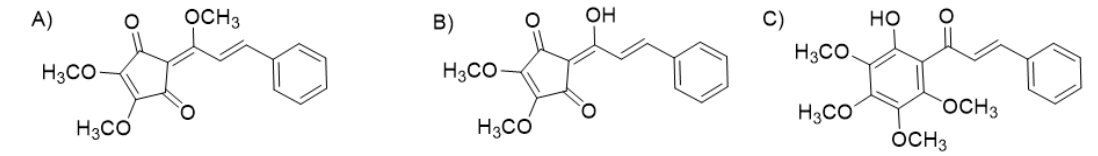
Figure 4. Structures of methyllinderone ( A ); linderone ( B ) and kanakugiol ( C ).